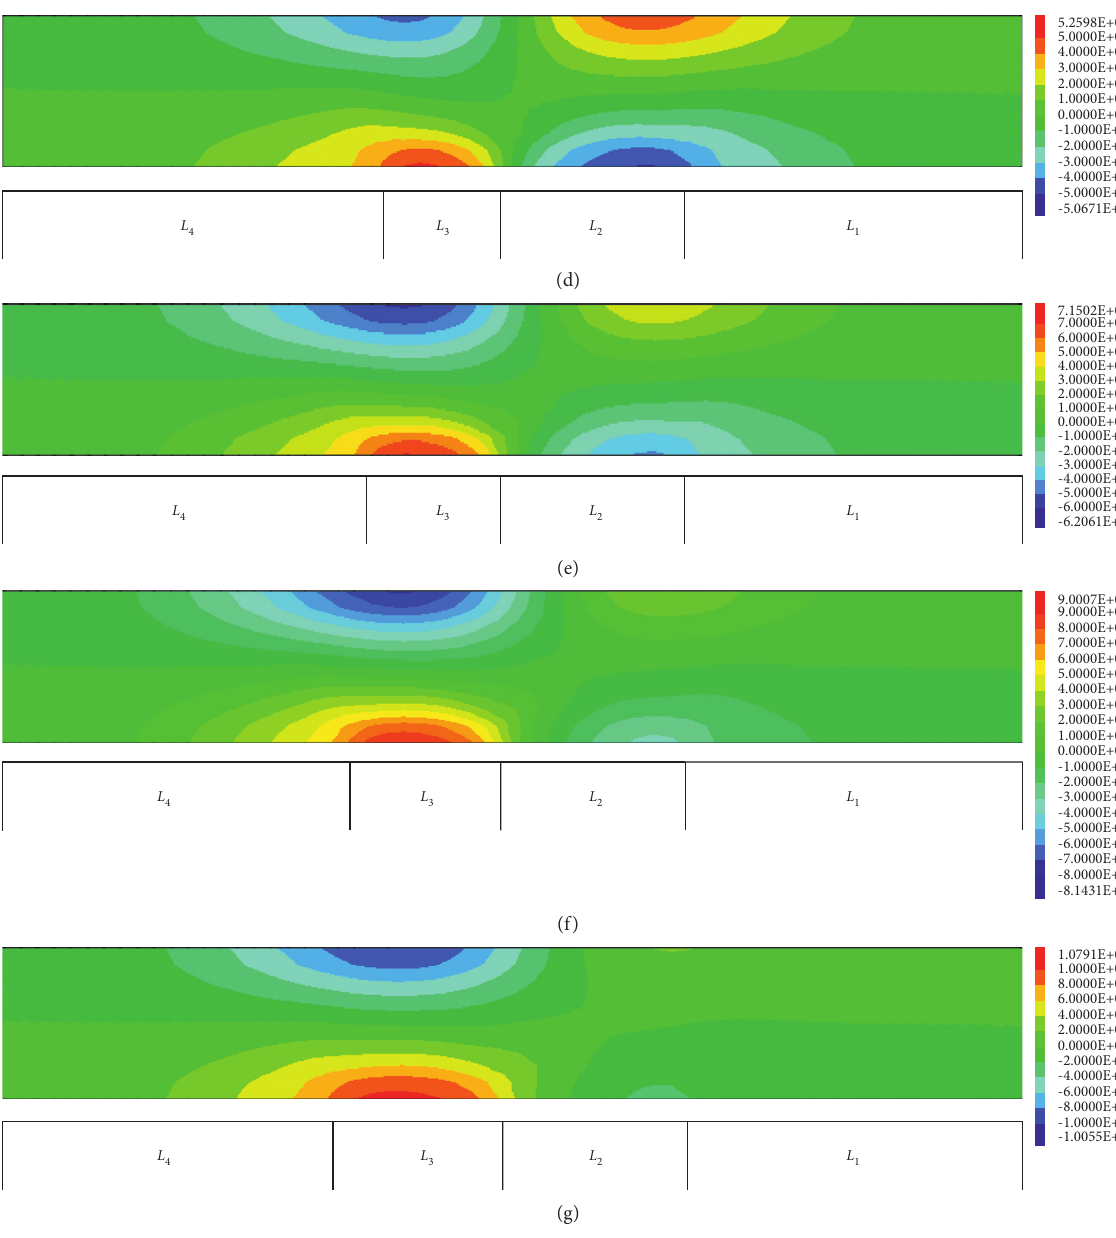
Figure 7: Immediate roof horizontal stress distribution cloud map of the retained roadway with different lengths of the lagging unsupported roof (unit: Pa). (a) Length of the lagging unsupported roof is 2.0 m. (b) Length of the lagging unsupported roof is 2.5m. (c) Length of the lagging unsupported roof is 3.0 m. (d) Length of the lagging unsupported roof is 3.5m. (e) Length of the lagging unsupported roof is